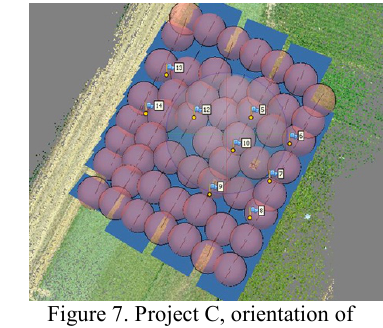
Figure 6. Project B, orientation of spherical images and extracted tie- points (sparse cloud).